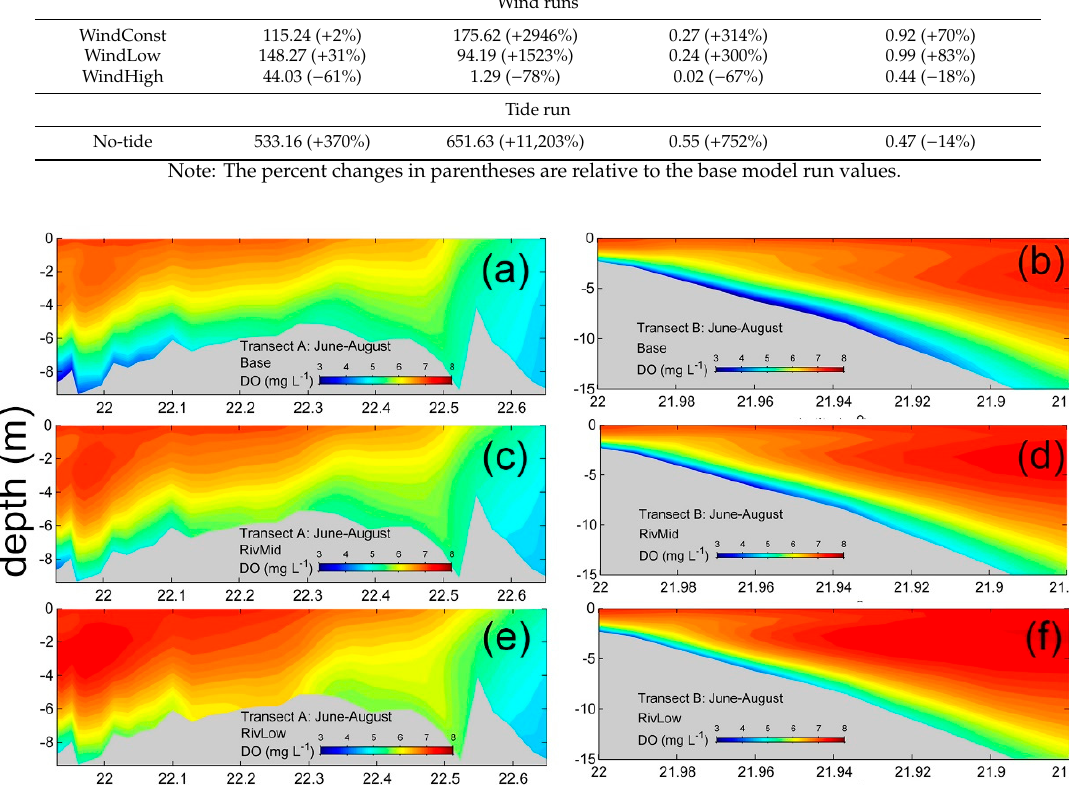
Figure 8. DO concentration profiles along transect A ( a , c , e ) and transect B ( b , d , f ) for different river discharge cases. Table 4. Hypoxic areas, volumes, and water thicknesses simulated by different model runs.